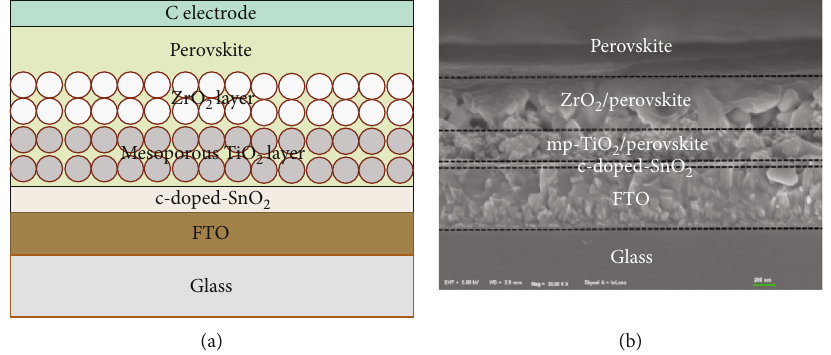
Figure 3: PSCs based on Zn-SnO compact layer: (a) structural schematic diagram; (b) SEM 2